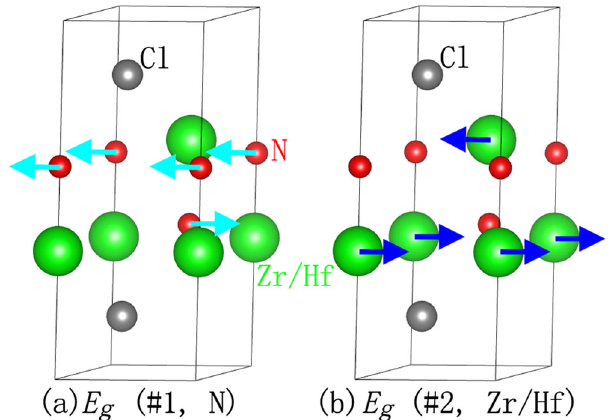
FIG. 5. Simplified crystal structure of ZrNCl = HfNCl . The mode with in-plane N vibration and arrows show (a) the E g (b) the E mode with in-plane Zr = Hf vibration. g